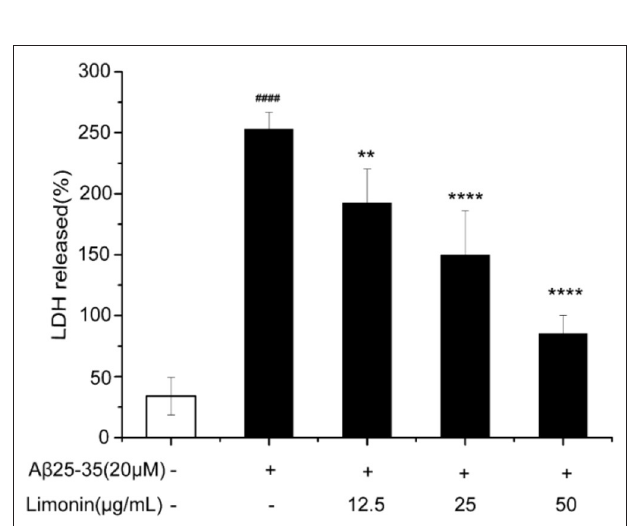
FIGURE 3 | Lactic dehydrogenase (LDH) activity was measured using an LDH assay kit. #### p < 0.0001 compared with the control group; ** p < 0.01 and **** p < 0.0001 compared with the A β 25 − 35